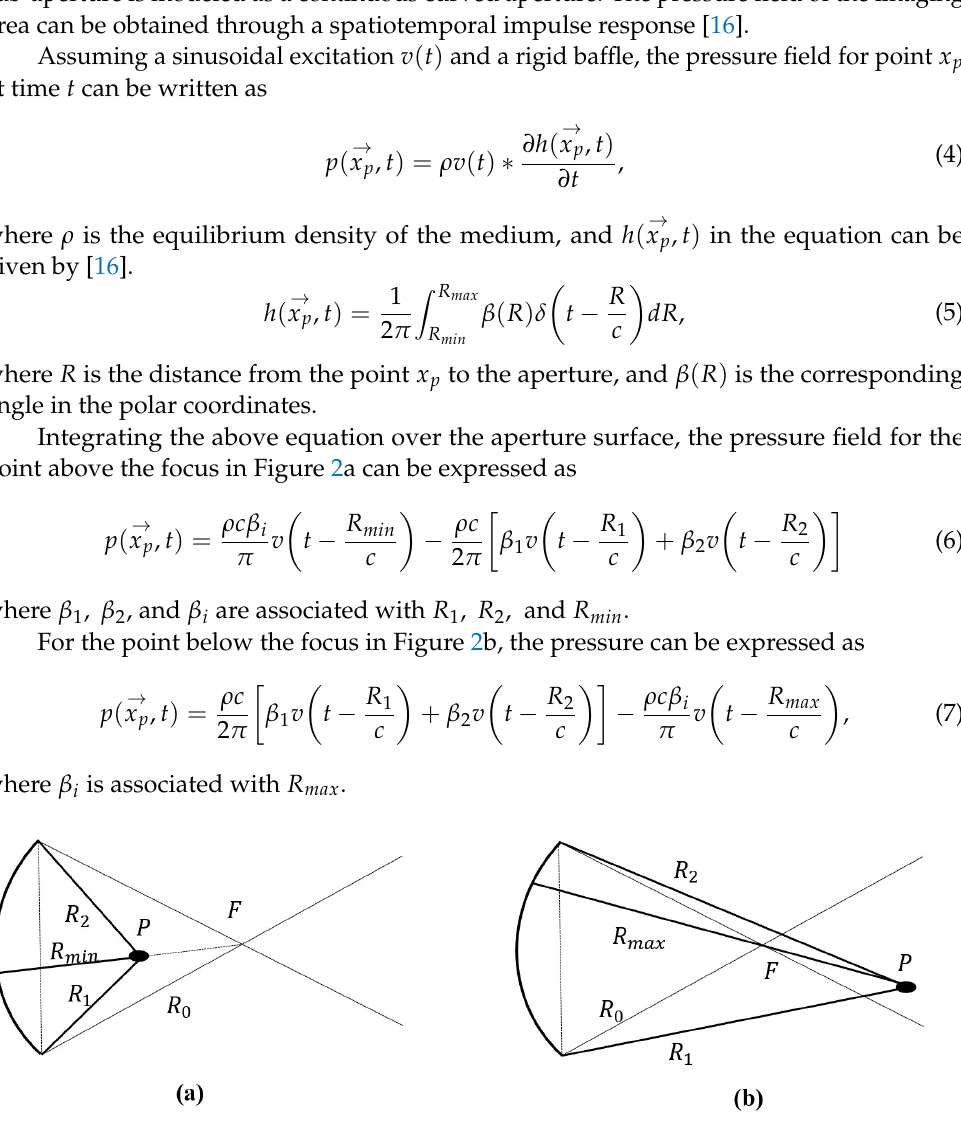
Figure 2. Geometries for calculating pressure field of transmit sub-aperture for spatial point 𝑃 in front of the focus ( a ) and behind the focus ( b ).